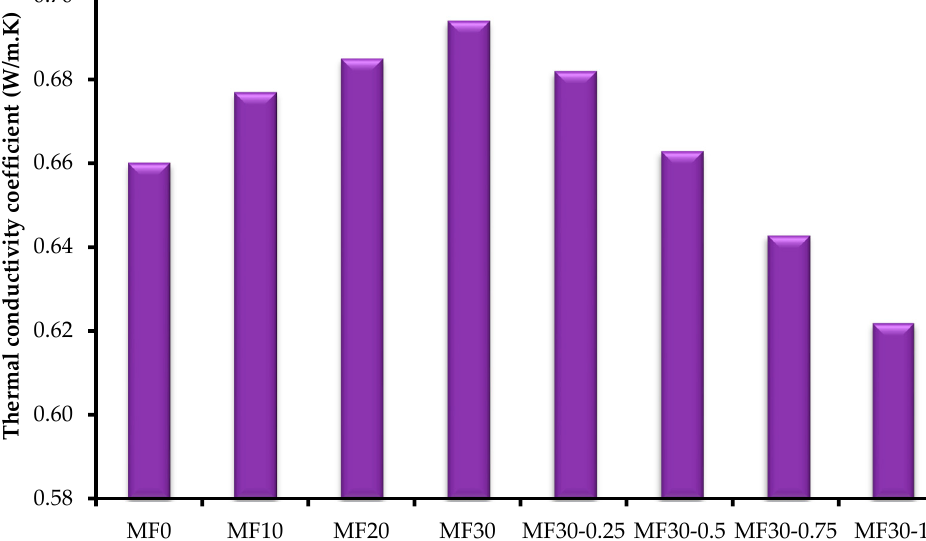
Figure 7. Thermal conductivity coefficient.